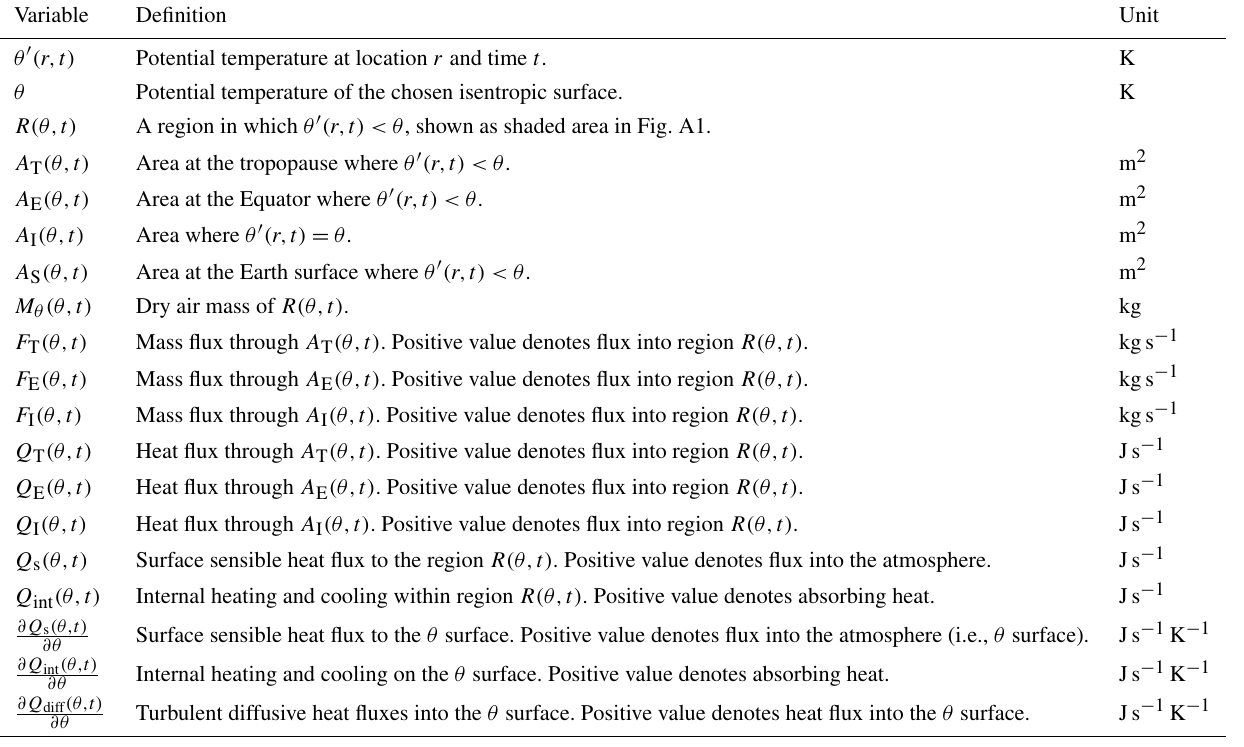
Table A1. Definition of